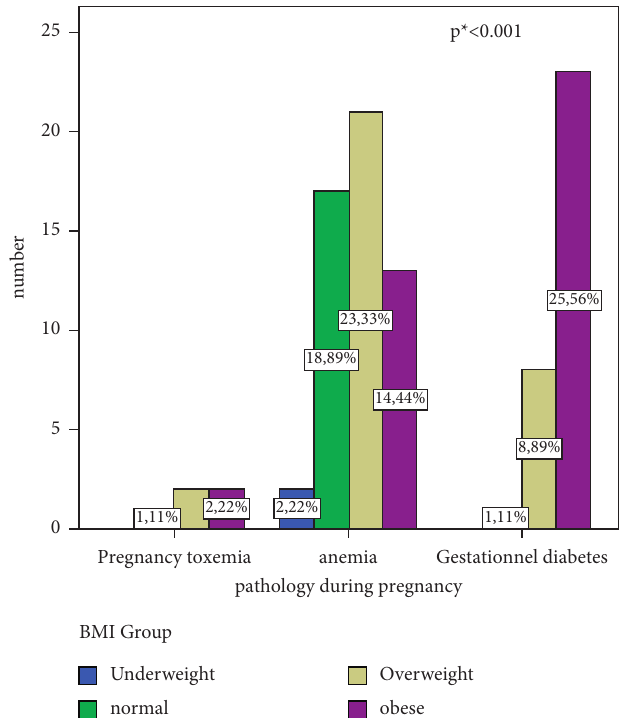
Figure 1: Distribution of parturients by body mass index and morbidity profile. Note: underweight: BMI < 18.5kg/m 2 ; normal: 18.5 ≤ BMI < 25kg/m 2 ; overweight: 25 ≤ BMI < 30kg/m 2 ; obese: BMI ≥ 30kg/m 2 . ∗ Fisher’s exact test. A value of p < 0 . 05 is considered